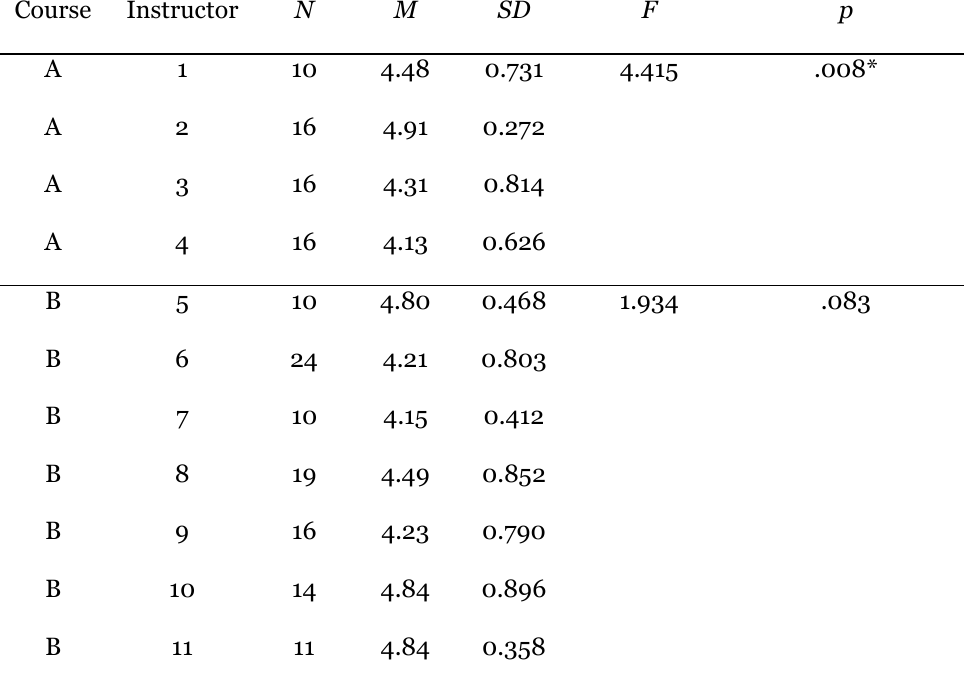
Descriptive Statistics of Instructional Design and Organization (DO) Scores as a Function of Instructor and